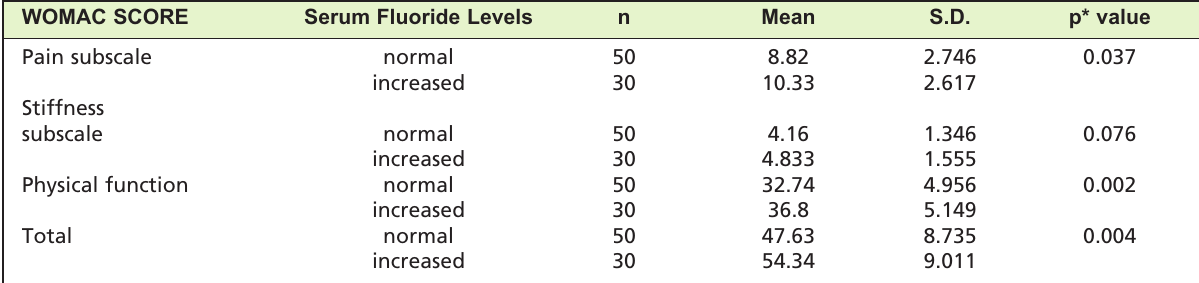
Comparison of WOMAC score with serum fluoride level Table II: